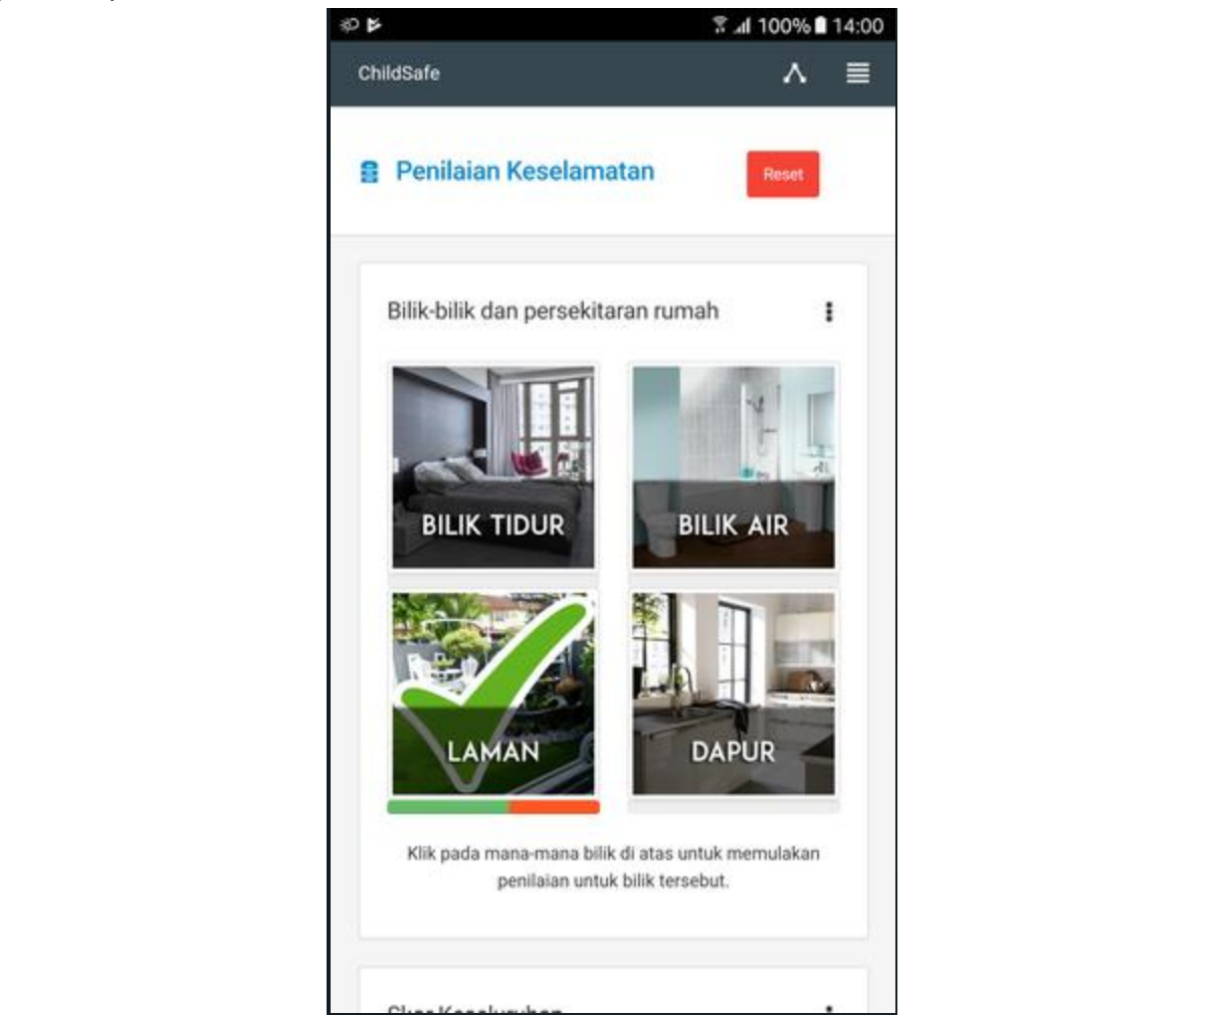
Figure 2. Safety